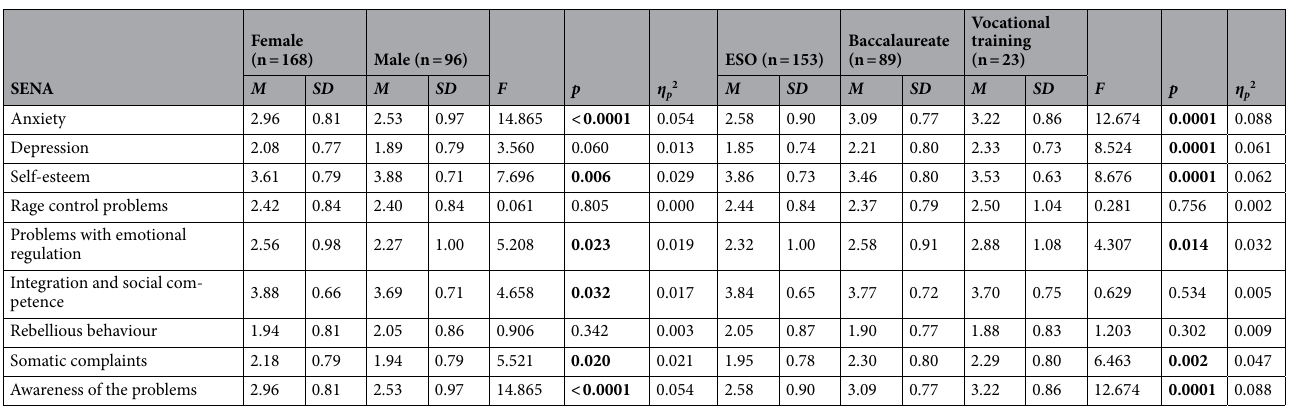
Table 5. Differences by gender and education in the mental health of teenagers between 13 and 18 years old during confinement. Statistically significant differences ( p < .05) are highlighted in bold. ESO Secondary, Middle School, Baccalaureate Sixth Forma, High